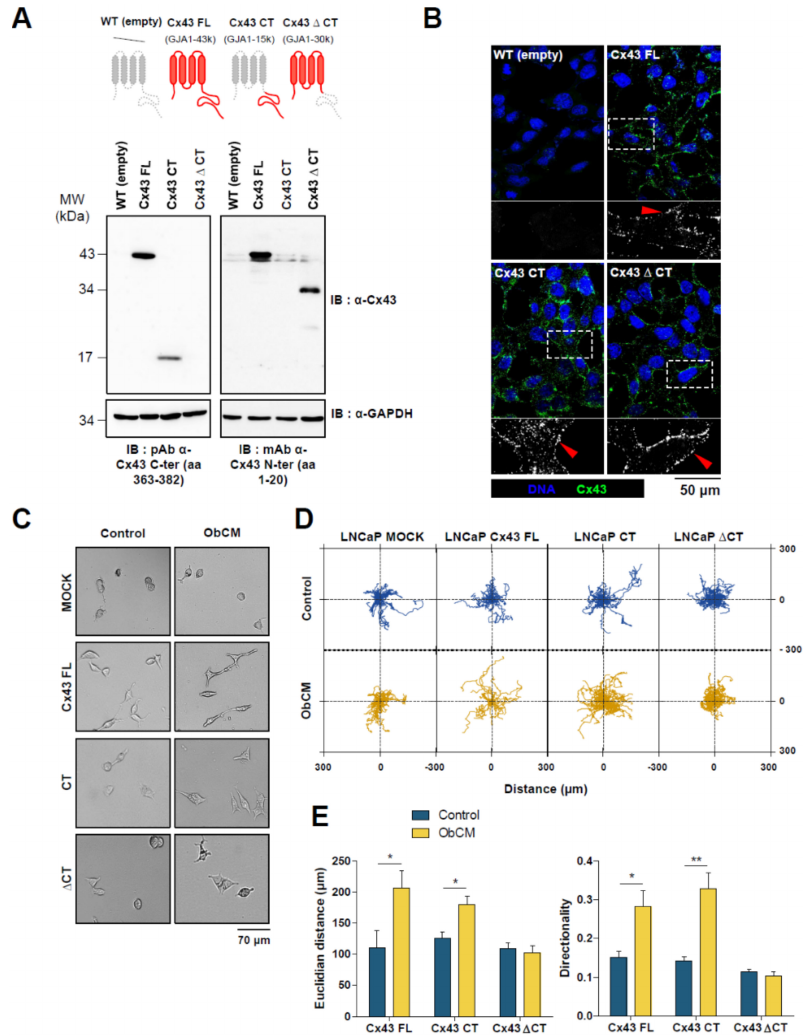
Figure 7. Channel mutants lacking carboxyl-tail of Cx43 fails to increase ObCM-induced migration. ( A ) Representative immunoblots of Cx43 in LNCaP cells transfected to stably express either full length human Cx43 (FL, 382 aa, 43kDa), C-ter truncated (CT, 139 aa, 15 kDa) or N-ter truncated ( ∆ CT, 242aa, 30 kDa) versions of the protein; left: Immunoblot with anti-Cx43 C-ter antibody and right: Immunoblot with anti-Cx43 N-ter antibody. ( B ) Immunostaining of Cx43 and its truncated forms in LNCaP cells (green); nuclei were DAPI-stained (blue). Enlarged images marked by white box show higher magnification of Cx43 staining for each cell line: Red arrowheads showing that Cx43 immunoreactivity was typically present as puncta at the cell surface. ( C ) Brightfield images of LNCaP cells expressing truncated versions of Cx43 after 17 h of stimulation with or without ObCM. ( D , E ), Quantitative analysis of single cell migration of LNCaP cells using time-lapse videomicroscopy. Cells were incubated for 17 h with either control media or osteoblasts-conditioned media (ObCM) and records were used for manual tracking of cell centroid trajectories. ( D ) Scaled spider graph showing the individual paths of 15 representative cells, starting from their initial position at T = 0. ( E ) quantification of Euclidian distance and directionality. Data represent the mean ± SEM from 3 di ff erent experiments (Cx43 FL CTRL n = 143; Cx43 FL ObCM n = 99; CT CTRL n = 165; CT ObCM n = 161; ∆ CT CTRL n = 97; ∆ CT ObCM n = 131). * p < 0.05; ** p <